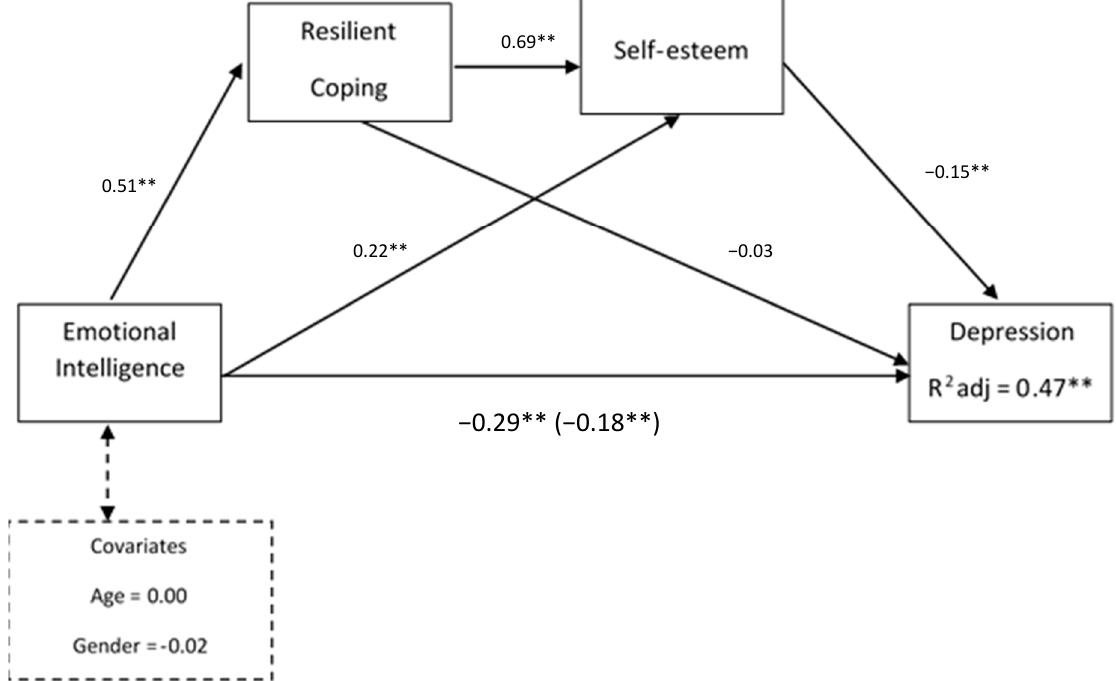
Figure 1. Multiple mediation model for the effect of EI on depressive symptoms via resilient coping and self-esteem controlling for age and gender as covariates. Notes: total effect (c-path) is given in parentheses; ** p < 0.01